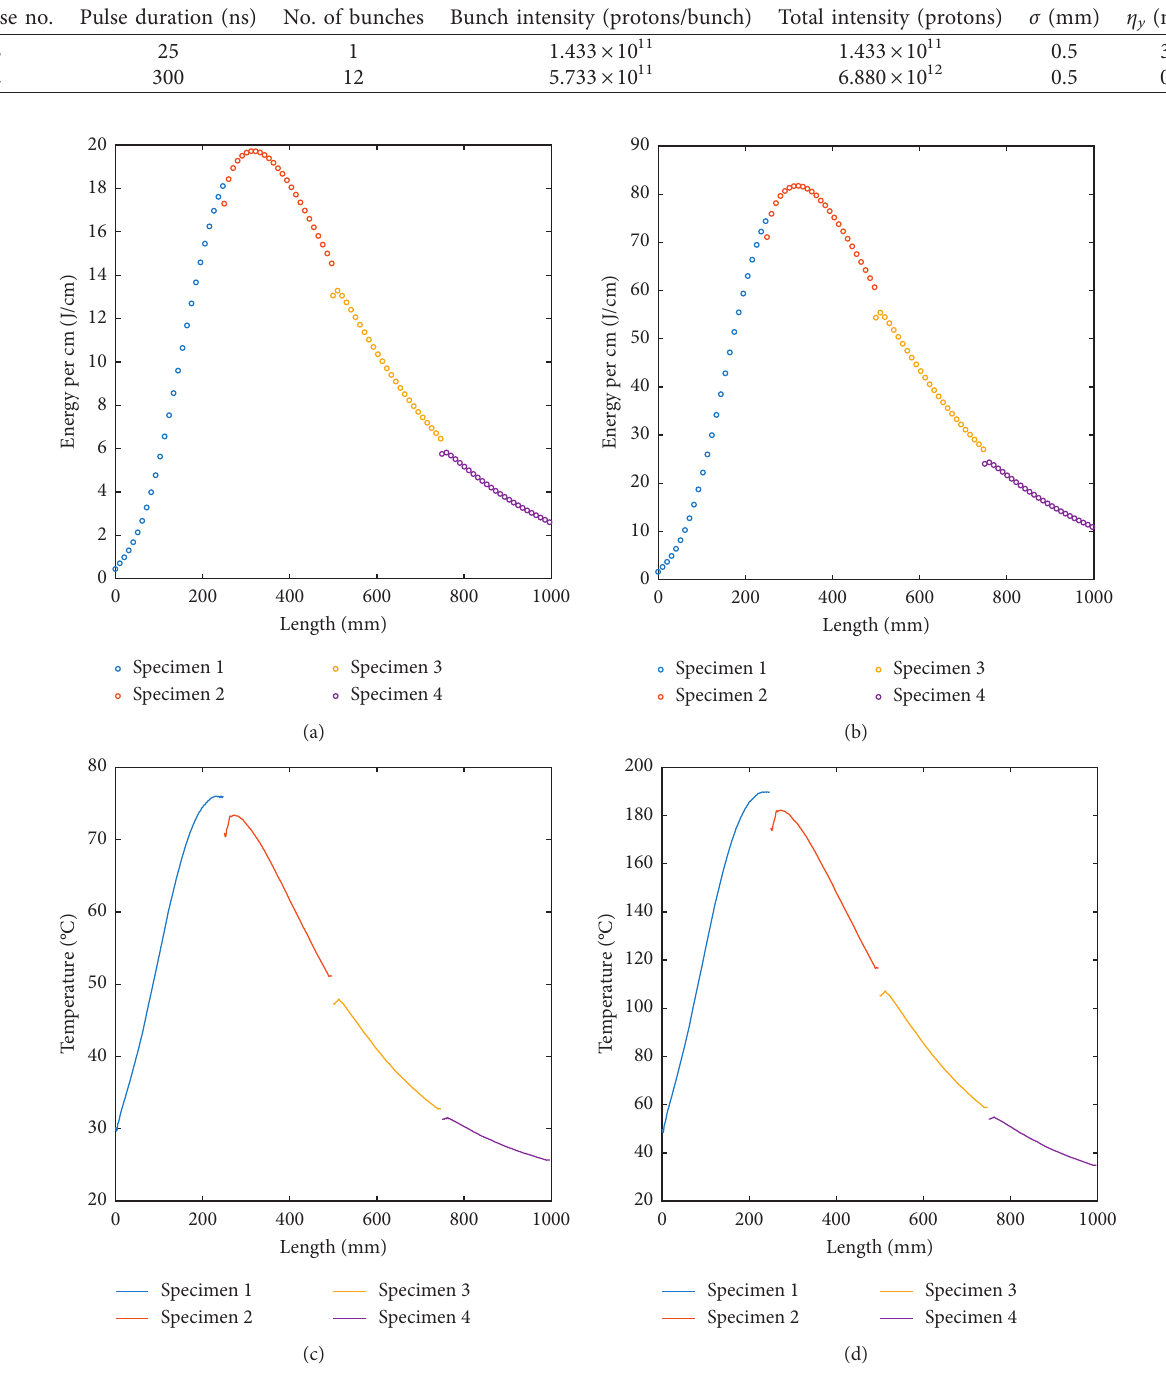
Figure 17: Energy deposited along the length of the specimens in the CuCD RHP target station for shots 128 (a) and 132 (b) and temperature along the length of specimens for each respective shot (c,